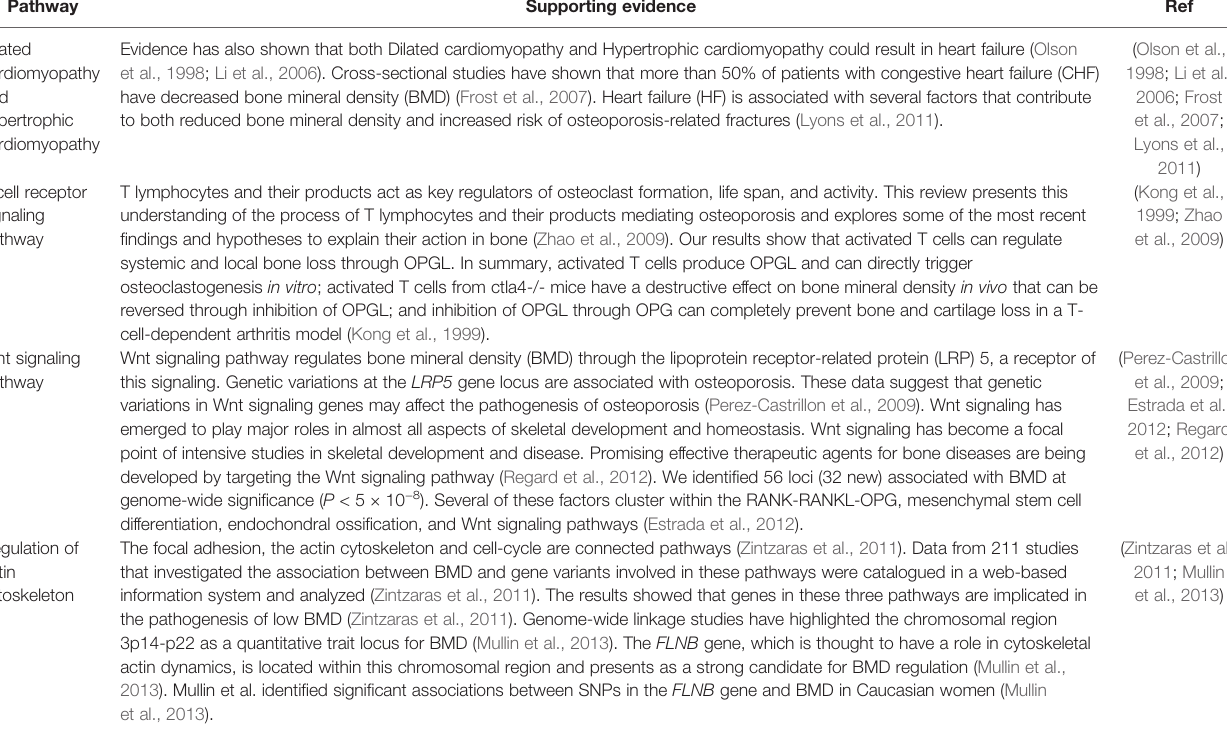
TABLE 2 | Literature evidences supporting that genes in measles pathway are associated with bone mineral density or osteoporosis.